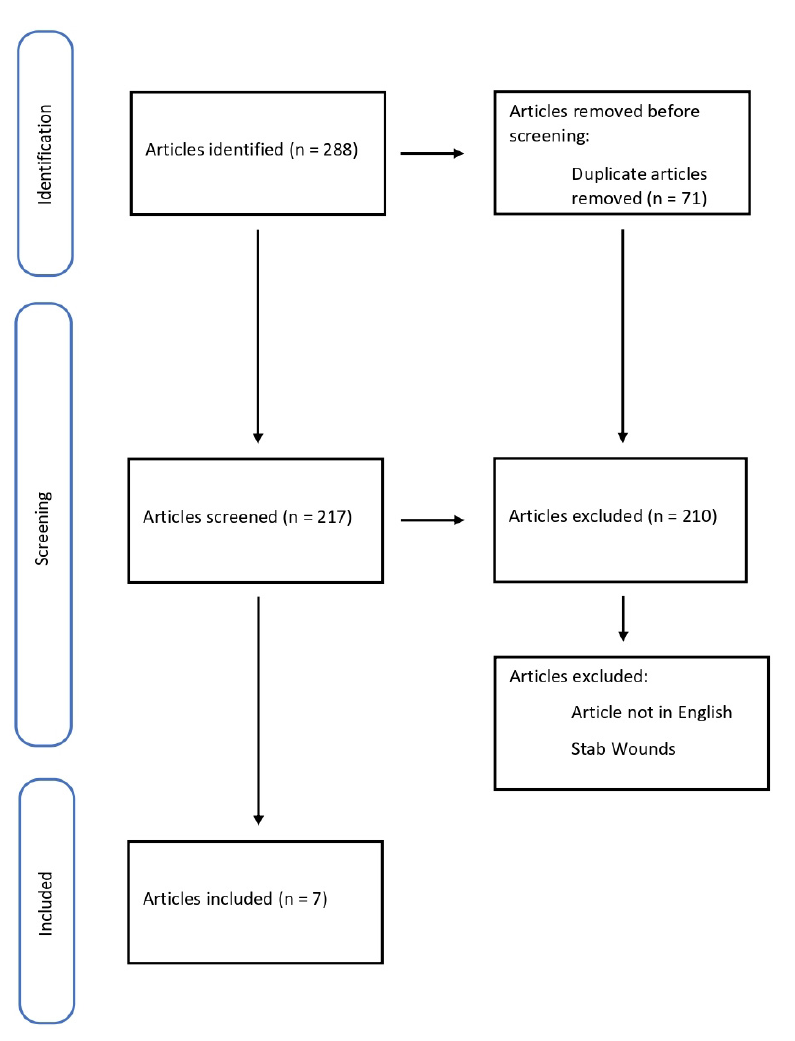
Fig. 1. Research methodology. Flow diagram illustrating studies included in and excluded from this systematic